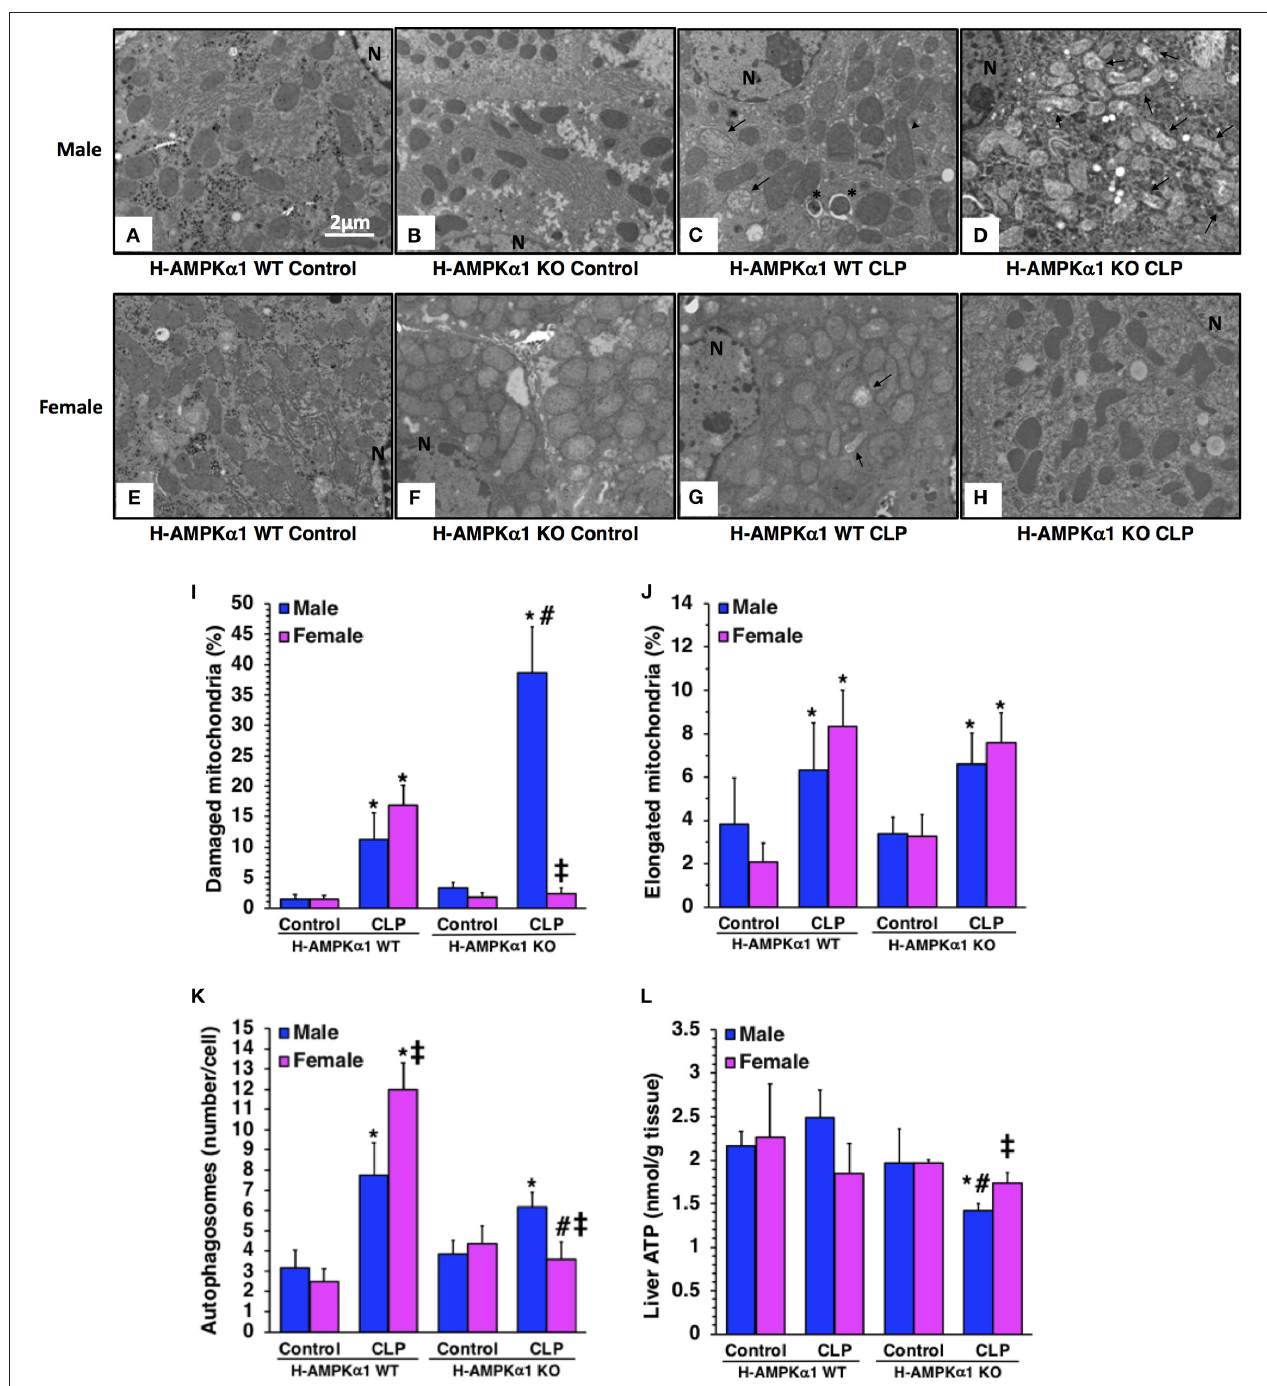
FIGURE 2 | Transmission electron microscopy of hepatocytes in hepatocyte-specific (H-AMPK α 1) wild-type (WT) and knock-out (KO) male (A–D) and female (E–H) mice at basal control condition or 18h after cecal ligation and puncture (CLP). Arrows, damaged mitochondria presenting translucent matrix, disrupted membrane and cristae; arrow heads, elongated mitochondria; asterisk, autophagic vescicles packed with mitochondria; N, nucleus. Quantification of damaged mitochondria (I) , elongated mitochondria (J) , and autophagosomes (K) of hepatocytes of hepatocyte-specific (H- AMPK α 1) wild-type (WT) and knock-out (KO) mice at 18h after cecal ligation and puncture (CLP). Liver sections were examined at transmission electron microscopy. Damaged, elongated mitochondria and autophagosomes were determined by using the NIH Image J software and expressed as percentage of total number of mitochondria in nine consecutive cells. Data are means ± SEM of 3–4 mice for each group. Liver ATP content (L) of hepatocyte-specific (H-AMPK α 1) wild-type (WT) and knock-out (KO) mice at 18h after cecal ligation and puncture (CLP). Data represents the mean ± SEM of 4–6 mice for each group. * P < 0.05 vs. sex-matched control mice; # P < 0.05 vs. sex-matched WT mice; ‡ P < 0.05 vs. male group of the same